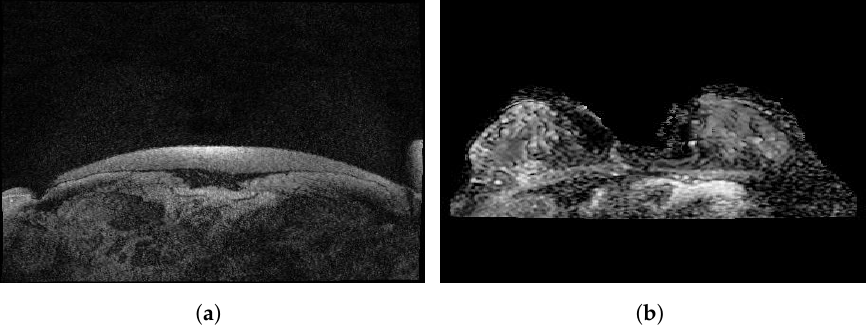
Figure 7. Sample images from ( a ): Duke-Breast-Cancer-MRI database; ( b ): RIDER Breast MRI database. Table 2 summarizes the characteristics of the reviewed public datasets. Table 2. Various public databases and their